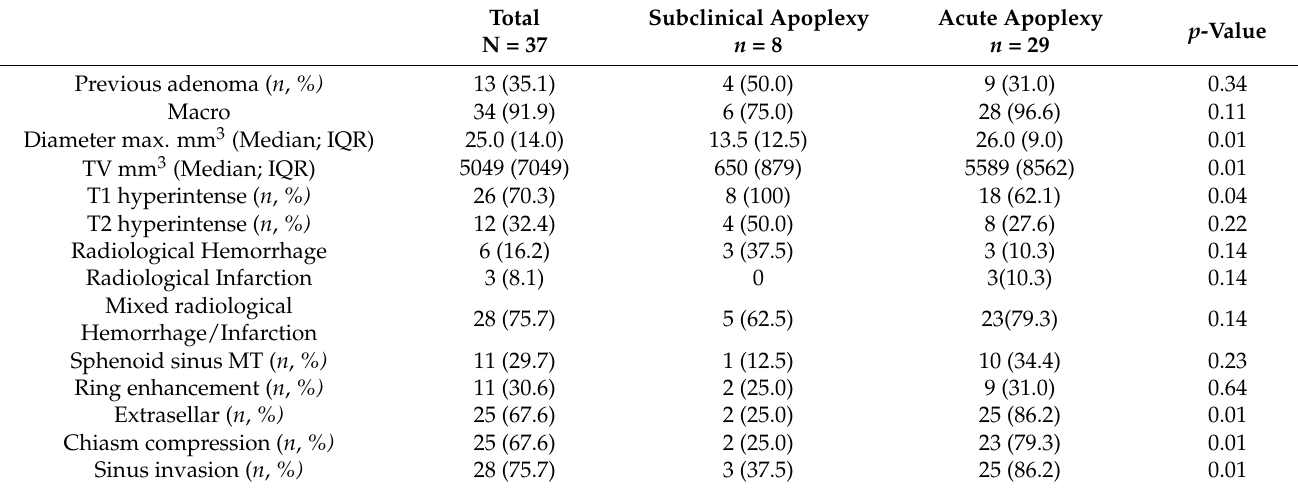
Table 2. Radiological characteristics of the different types of pituitary